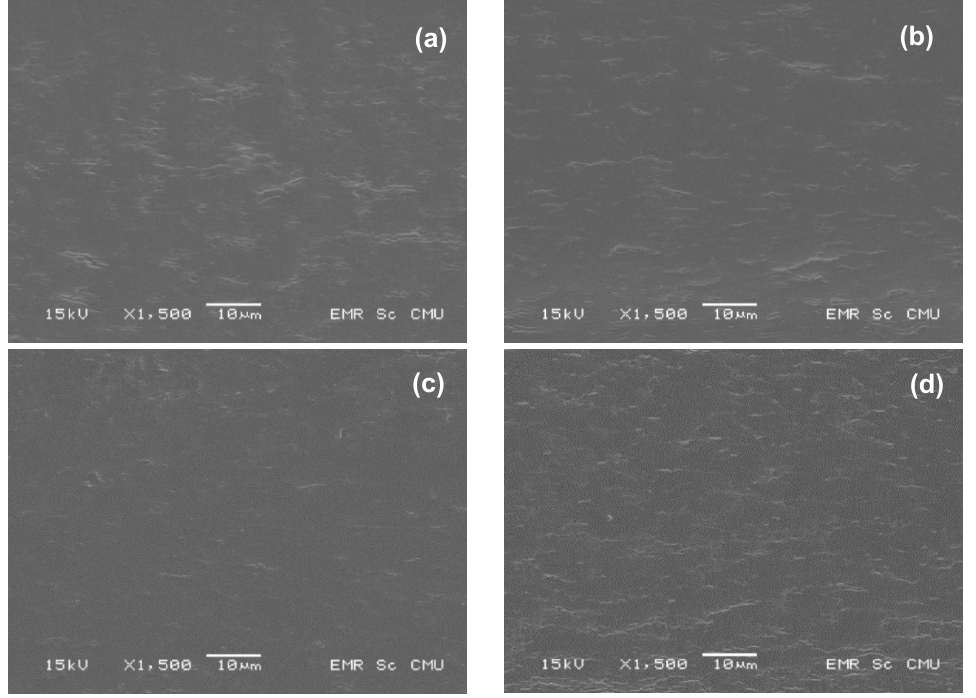
Figure 1. SEM images of ( a ) RS/CMCh film (control) and RS/CMCh film with ( b ) 2.5% ppl ( c ) 5.0% ppl and ( d ) 10.0% ppl.